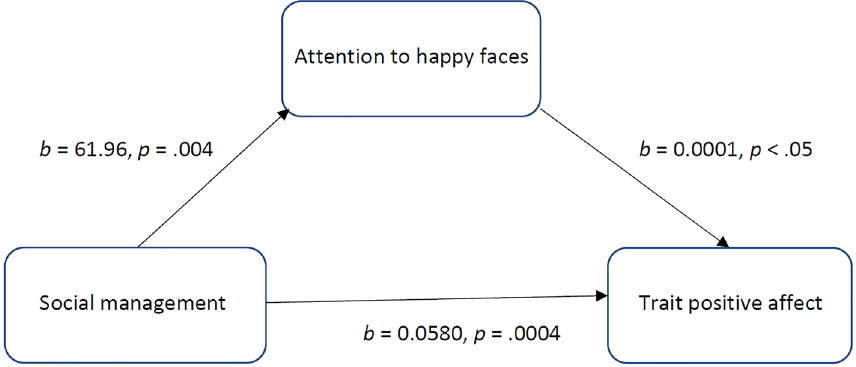
Figure 2. The mediating effect of attention to happy faces (dwell time on happy faces) in the relationship between social management and trait positive affect (PANAS). All presented effects are unstandardized.